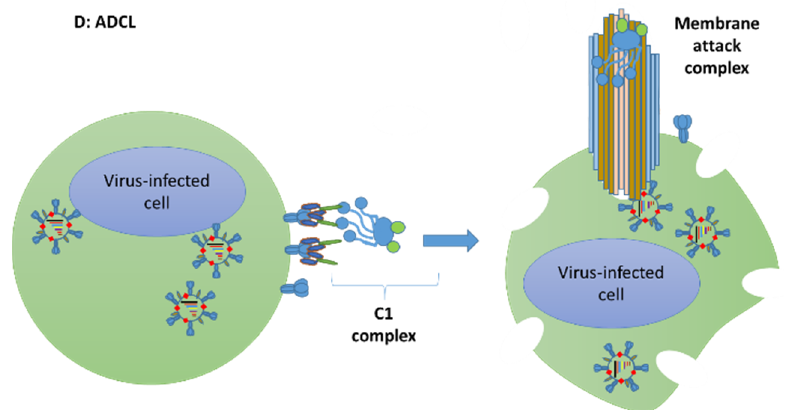
Figure 1. Mechanisms of antibody protection via passive immunization. This figure outlines the possible mechanisms by which antibodies could mediate instant protection when administered either as a prophylaxis or treatment. ( A ) Broadly neutralizing antibodies interact with HA interfering with the virus attachment to host cell. ( B ) Opsonized infected host cells attract natural killer (NK) cell destruction via the process of antibody-dependent cellular cytotoxicity (ADCC). ( C ) Opsonized virus particles activate their phagocytosis by polymorphonuclear cells (PMN) via the process of antibody-mediated cell phagocytosis. ( D ) Virus infected cells displaying the surface proteins of replicating viruses attract the assembly of the classical complement proteins forming a membrane attack complex that destroys the cell by osmosis in a process called antibody-dependent cell lysis (ADCL).